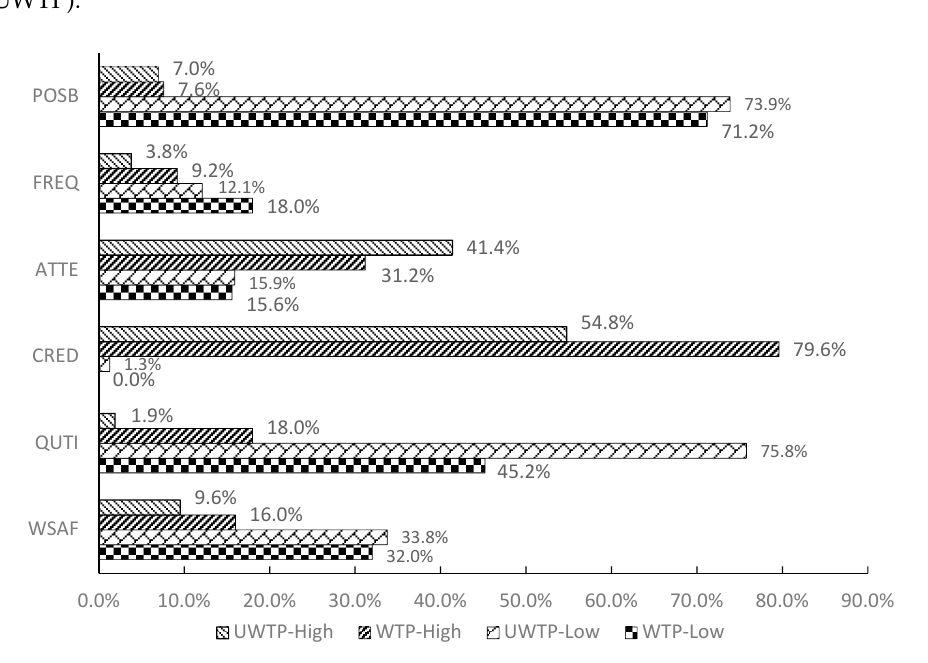
Figure 4. Comparison of attitudes toward fruit safety between WTP and UWTP consumers. Note: For the purpose of presentation, the five digit-scale categories were combined into three: “high” in the figure combines the frequencies of “very high” and “high” responses; “low” combines the frequencies of “very low” and “low” responses.